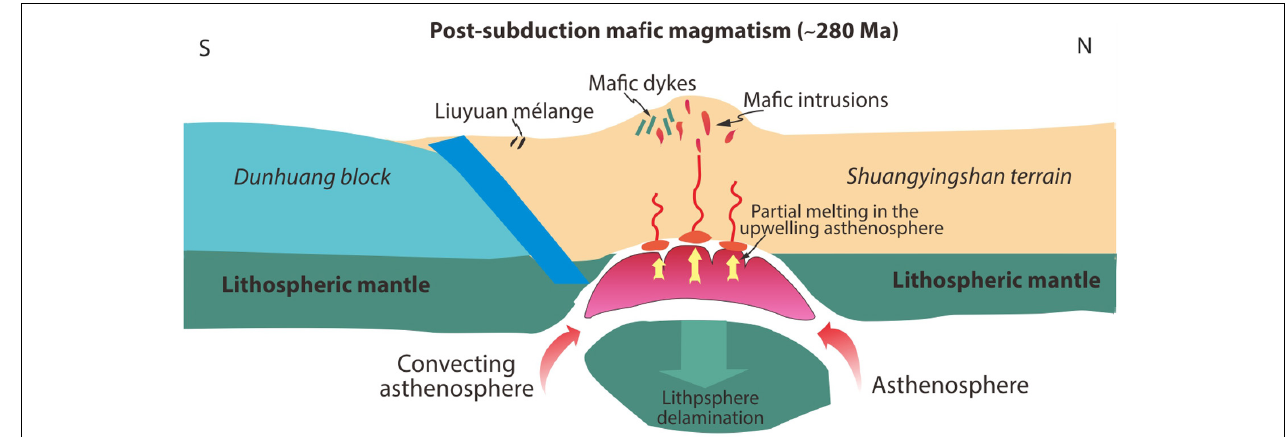
FIGURE 9 | Schematic diagrams for the Permian tectonic evolution of the southern Beishan area. Lithospheric delamination leading to extensional tectonism and partial melting of upwelling asthenospheric mantle and overlying lithospheric mantle.